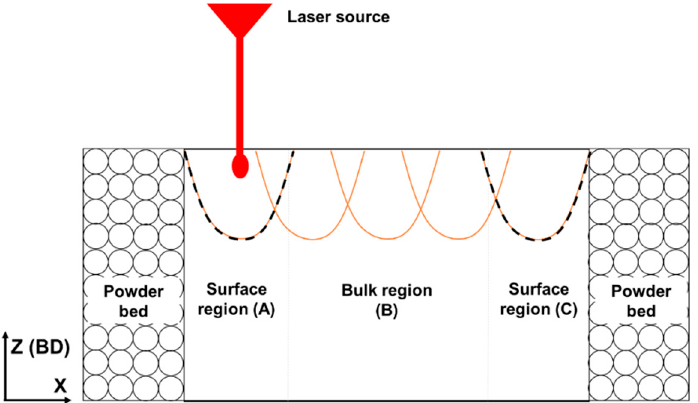
Figure 12. Illustration of melt pools at the surface and interior of a specimen. The bulk scanning (orange) happens once, whereas contour scanning (black, dotted) re-melts the surface melt pool, thus causing a softening effect.